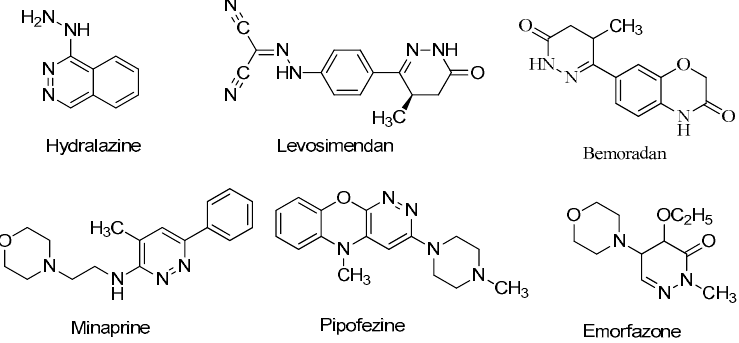
Figure 2. Antihypertensive, antidepressant, and anti-inflammatory pyridazinone derivatives.